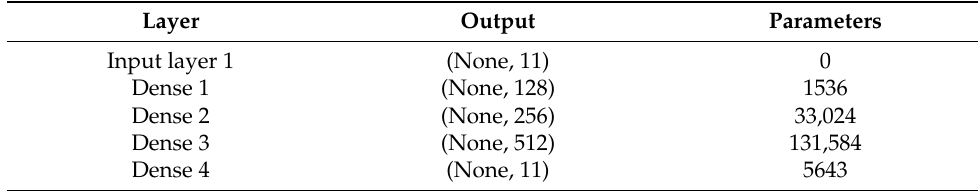
Table 3. GAN and WGAN models generator